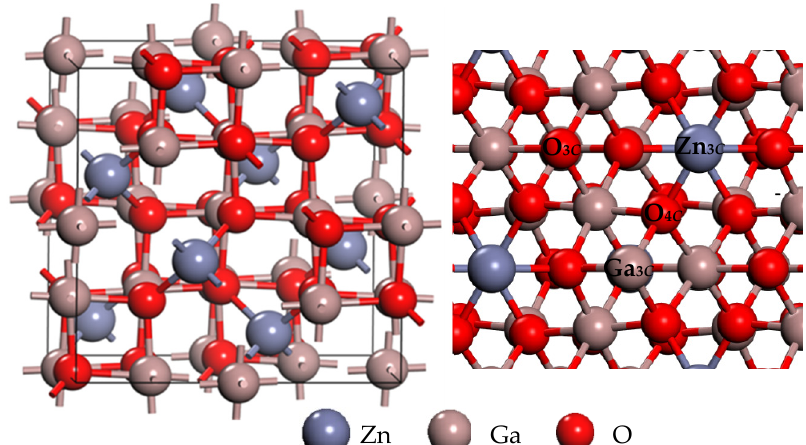
Figure 1 . Left and right panels illustrate bulk ZnGa 2 O 4 crystal structure and top view of the adsorption sites O 3 C , Zn 3 C , O 4 C , and Ga 3 C on ZnGa 2 O 4 (111) surface, respectively. These sites are labeled for the adsorption sites of the Pd atom.